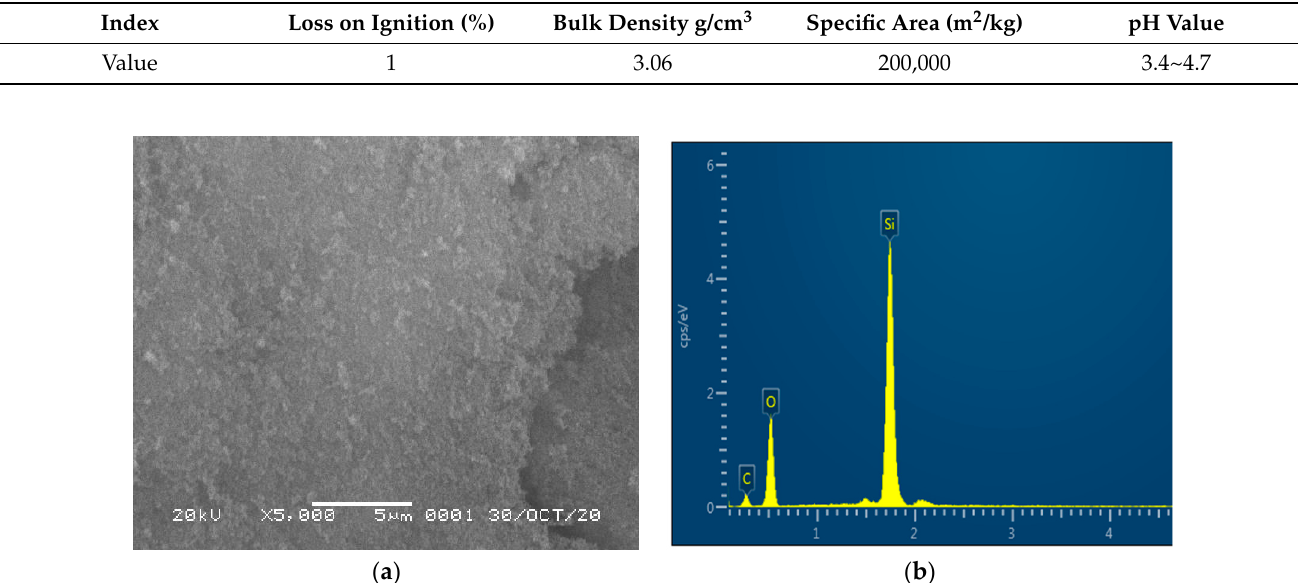
Table 4. Physical and mechanical indexes of nano silica.